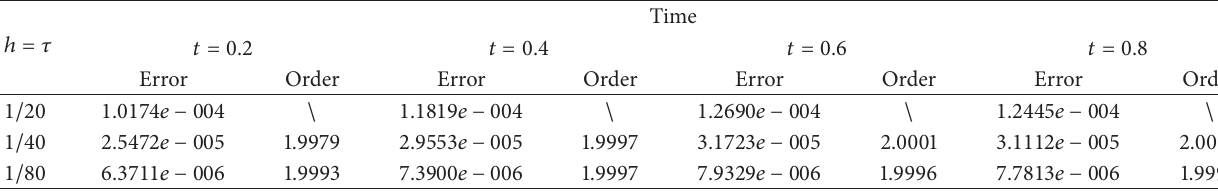
Table 1: The errors of ‖𝑢 𝐽 − 𝑈 𝐽 ‖ at different time.